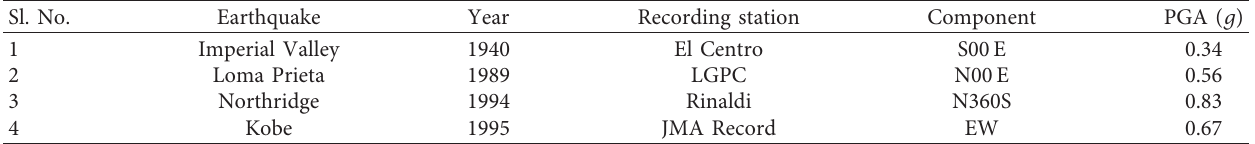
Table 3: Details of the earthquake ground motion.